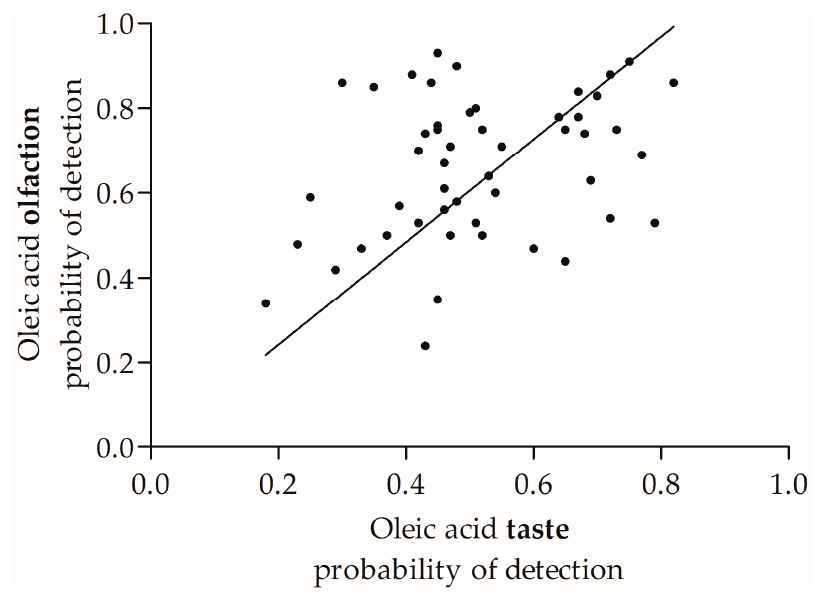
Figure 3. Scatterplot of the relationship between oleic acid olfaction and taste (probability of detection), the weighted average across all three sessions.